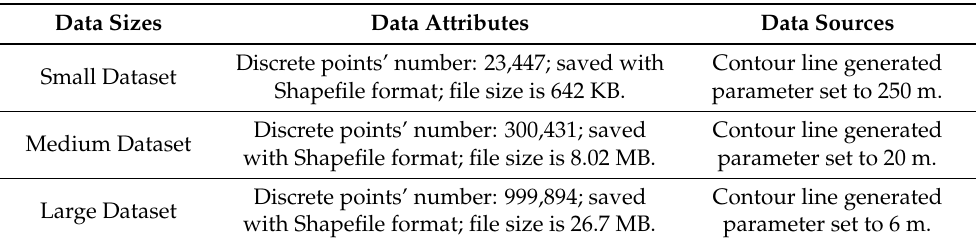
Table 2. Details of the datasets used in the